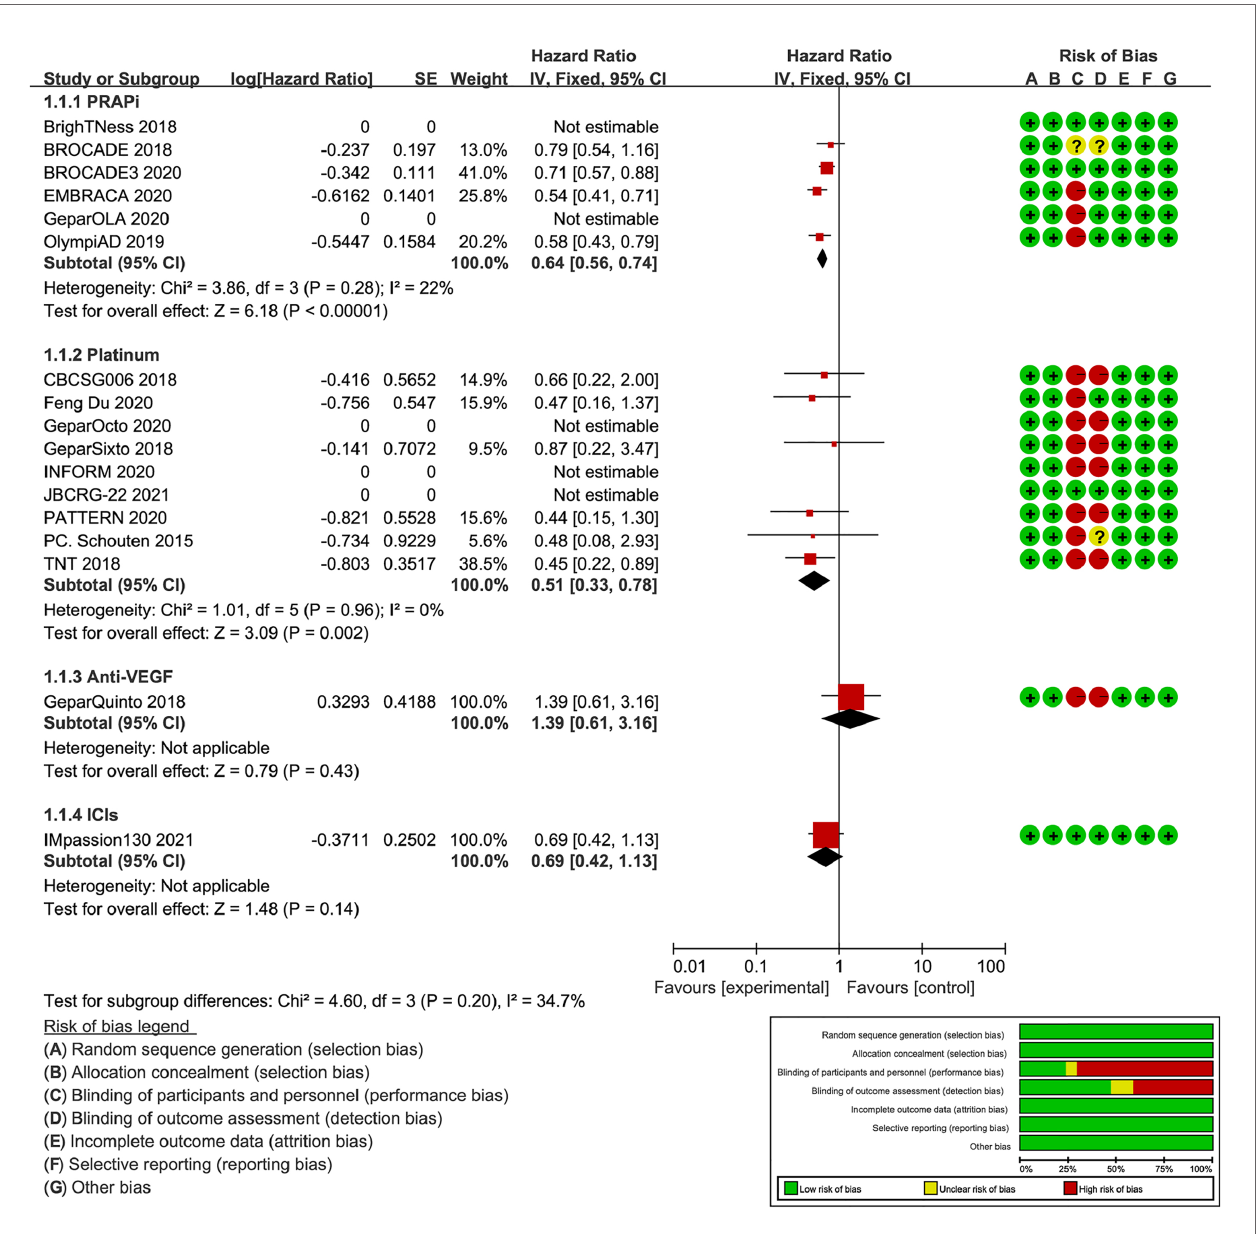
FIGURE 2 | Forest plot of PFS results and risk of bias graph for each included study. On the left, the authors ’ name, publication years, and the logHR results of individual studies are listed. Subgroup analysis is conducted according to different intervention drugs, including PARPi, platinum, anti-VEGF, and ICIs. The forest plot in the middle shows the PFS results of each study, and the center of diamonds represent the pooled HR. The center is left to vertical line, favoring the experimental groups. The horizontal tips represent the 95%CIs. The right side of the fi gure shows the risk of bias assessment for each study according to the Cochrane